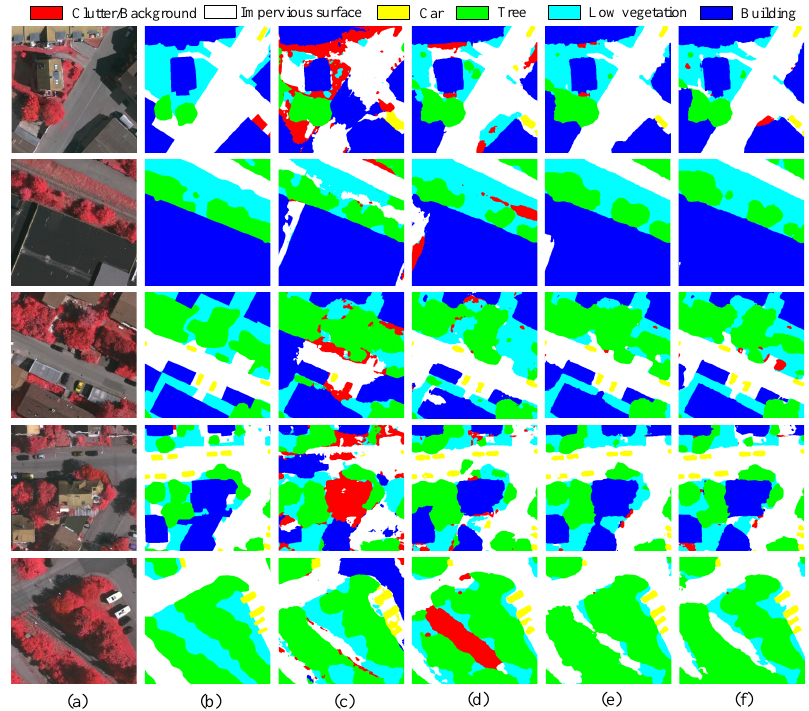
Figure 6. Qualitative results of the cross-domain semantic segmentation on Potsdam IRRG → Vai- hingen IRRG. ( a ) Target images. ( b ) Ground truth. ( c ) Baseline. ( d ) CSC-Trans. ( e ) CSC-Aug and ( f )